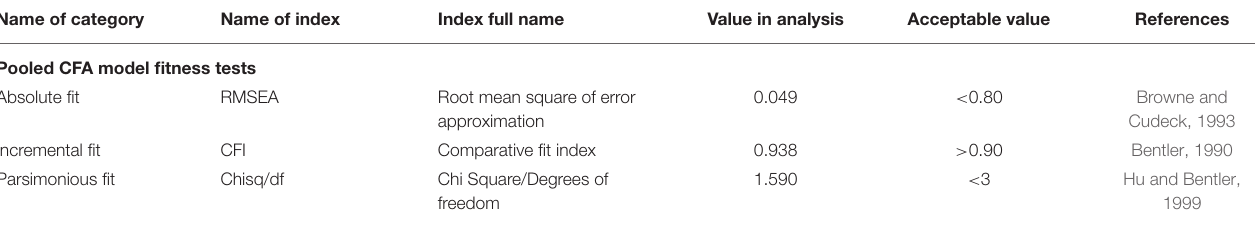
TABLE 2 | Pooled CFA model fitness tests.